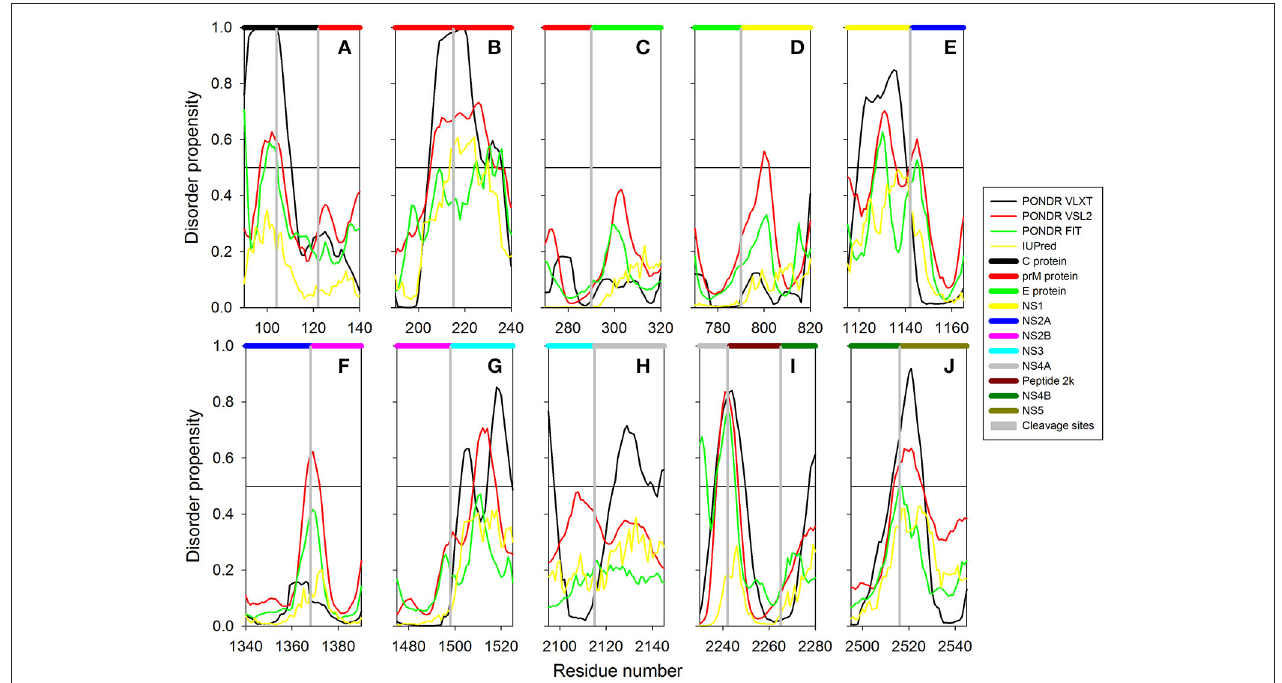
FIGURE 3 | The role of intrinsic disorder in maturation of individual proteins of Zika virus. Plots shows position of cleavage sites (gray vertical bars) in relation to disorder profiles at the junction between the individual proteins within the polyprotein. (A) A cleavage site between proteins C (black horizontal bar) and prM (red horizontal bar). A cleavage site at the position 104 within the pro-protein C leading to the removal of propeptide (residues 105–122) is also shown. (B) A cleavage site within the prM protein leading to generation of proteins Pr and M. (C) A cleavage site between the proteins prM (red horizontal bar) and E (green horizontal bar). (D) A cleavage site between the proteins E (green horizontal bar) and NS1 (yellow horizontal bar). (E) A cleavage site between the proteins NS1 (yellow horizontal bar) and NS2A (blue horizontal bar). (F) A cleavage site between the proteins NS2A (blue horizontal bar) and NS2B (pink horizontal bar). (G) A cleavage site between the proteins NS2B (pink horizontal bar) and NS3 (cyan horizontal bar). (H) A cleavage site between the proteins NS3 (pink horizontal bar) and NS4A (gray horizontal bar). (I) Cleavage sites between the protein NS4A (gray horizontal bar) and the peptide 2k (dark red horizontal bar) and the peptide 2k (dark red horizontal bar) and protein NS4B (dark green horizontal bar). (J) A cleavage site between the proteins NS4B (dark green horizontal bar) and NS5 (dark yellow horizontal bar).